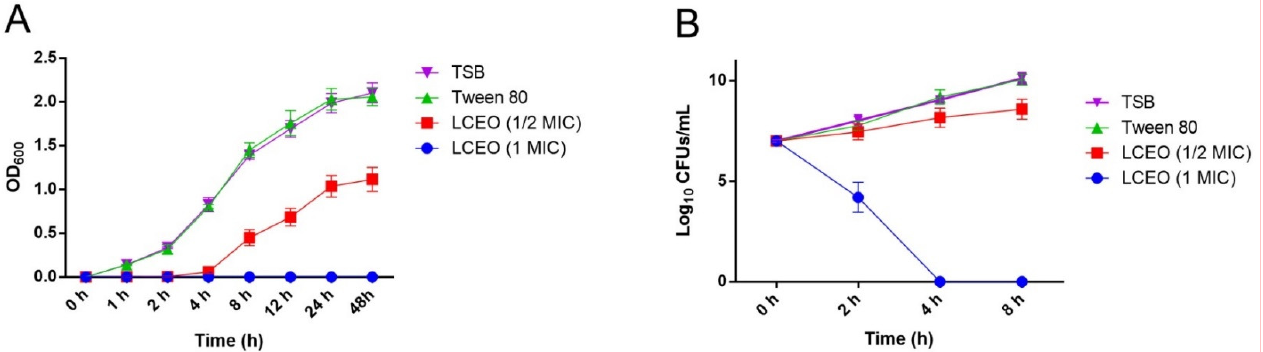
Figure 1. Growth curve ( A ) and time kill curve ( B ) assay of LCEO on A. baumannii 17. In tween 80 and LCEO (1 MIC) group, they had the same concentration (1.08 mg/mL) of tween 80.